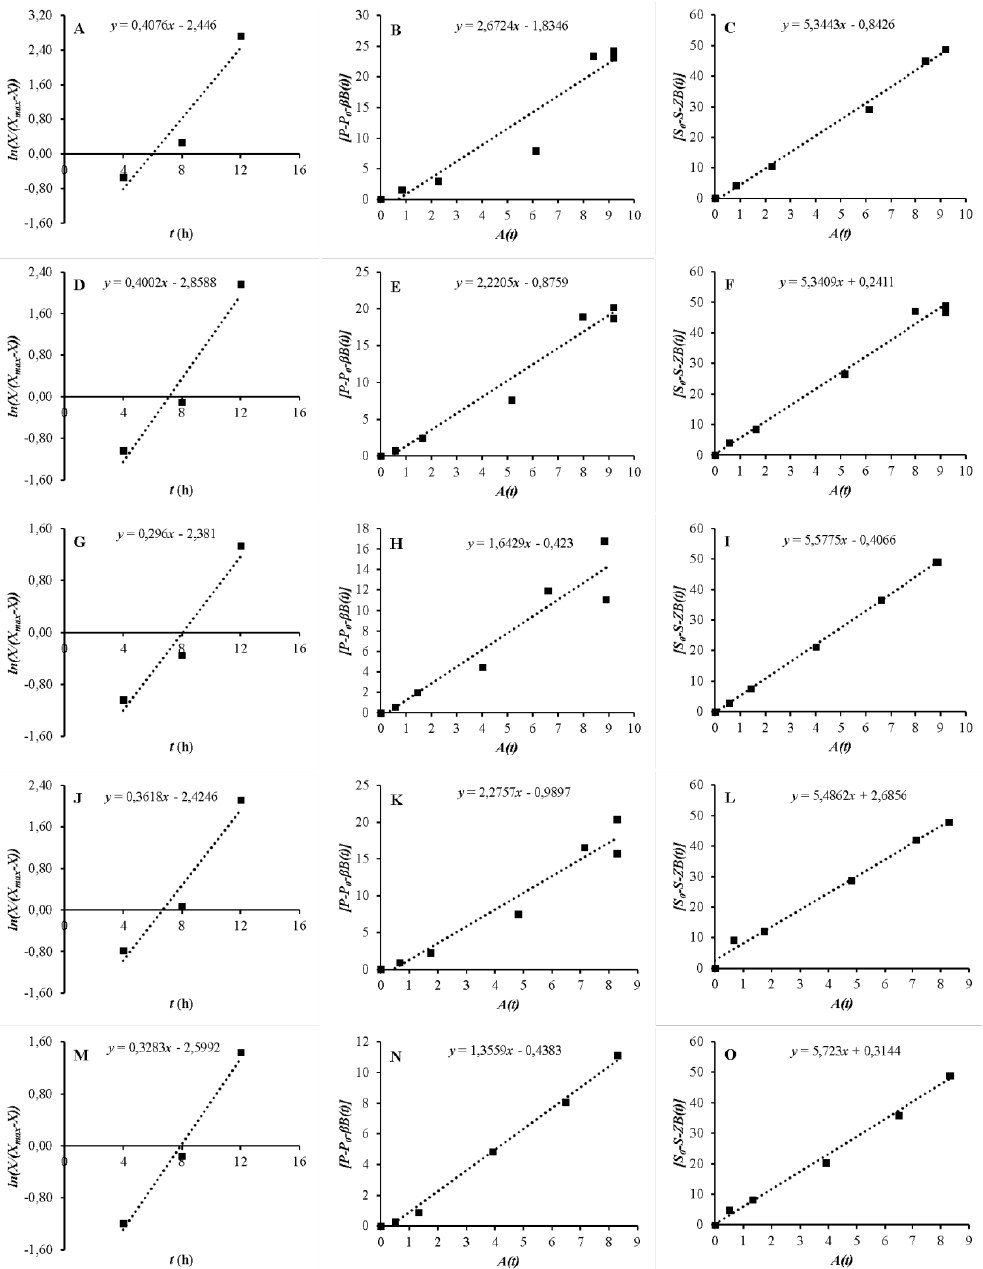
Figure 1. Determination of µ max , X 0 ( A , D , G , J , and M ), a ( B , E , H , K , and N ), and 𝛾 ( C , F , I , L , and O ).